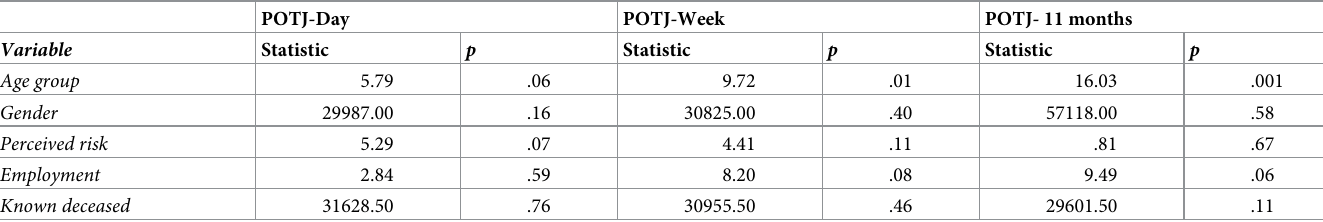
Table 2. Outcomes of the analysis of the effect of demographic factors on POTJ’s.